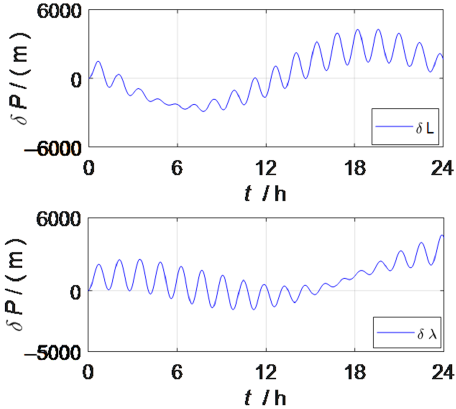
Figure 2. Position error of the strapdown inertial navigation system.